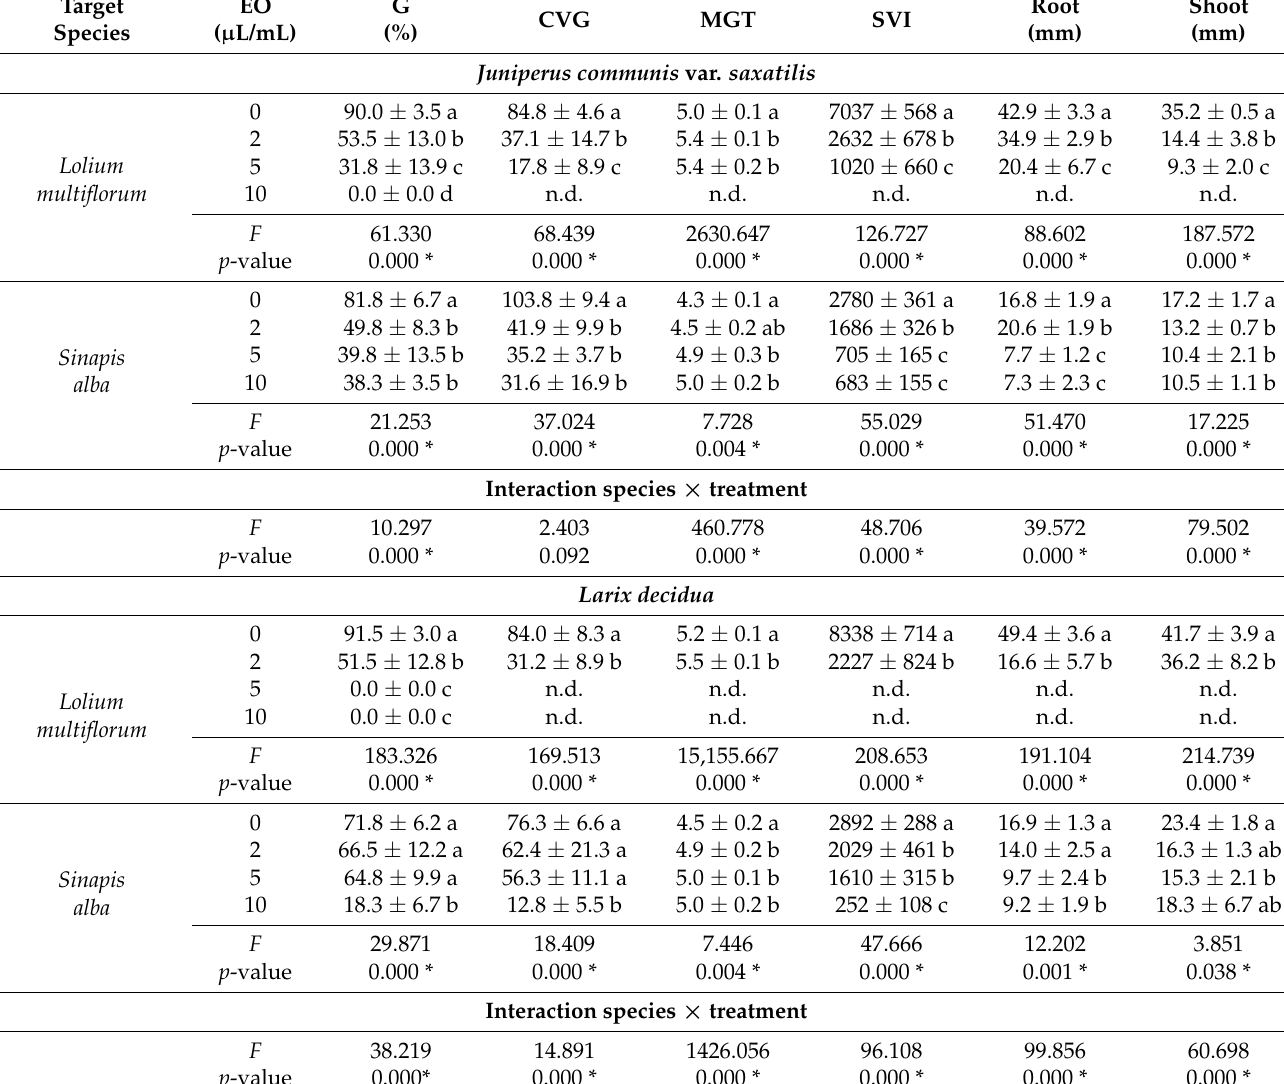
Table 8. Germination and growth values of two target species ( Lolium multiflorum and Sinapis alba ) under the phytotoxic effects of different doses of Juniperus communis var. saxatilis and Larix decidua EOs using filter paper as a